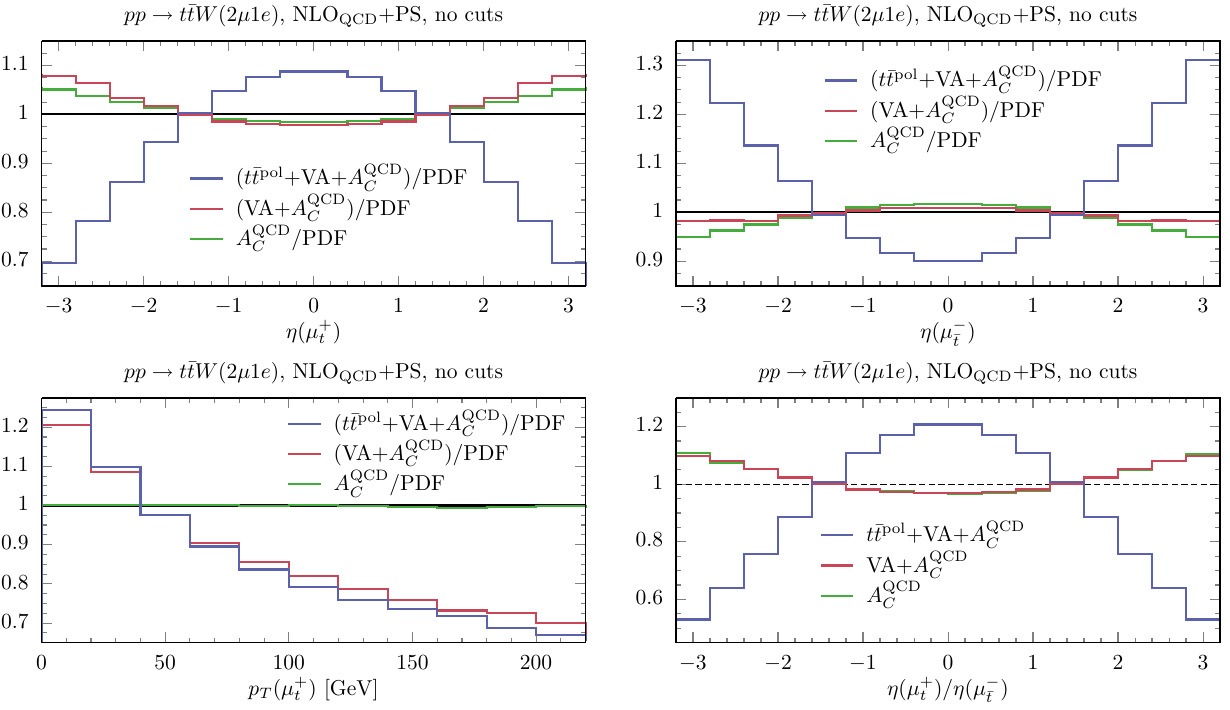
Fig. 1 Origin of asymmetries in top pair decay products. The muons in these plots exclusively originate from the top-quark pair. The sum of these effects (blue line) is included in the modern MC simulations